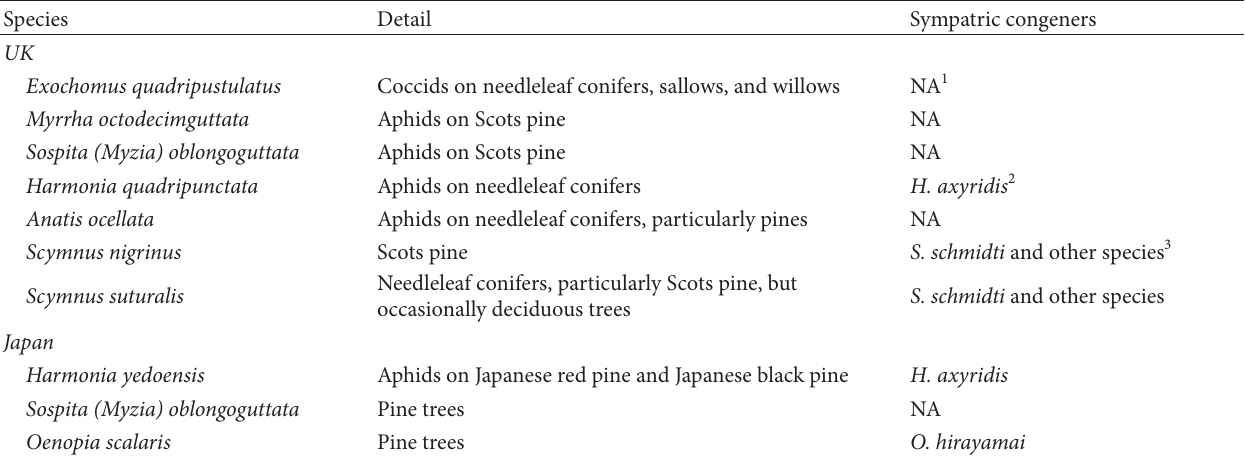
Table 3: Conifer-associated specialist ladybird species in the UK and